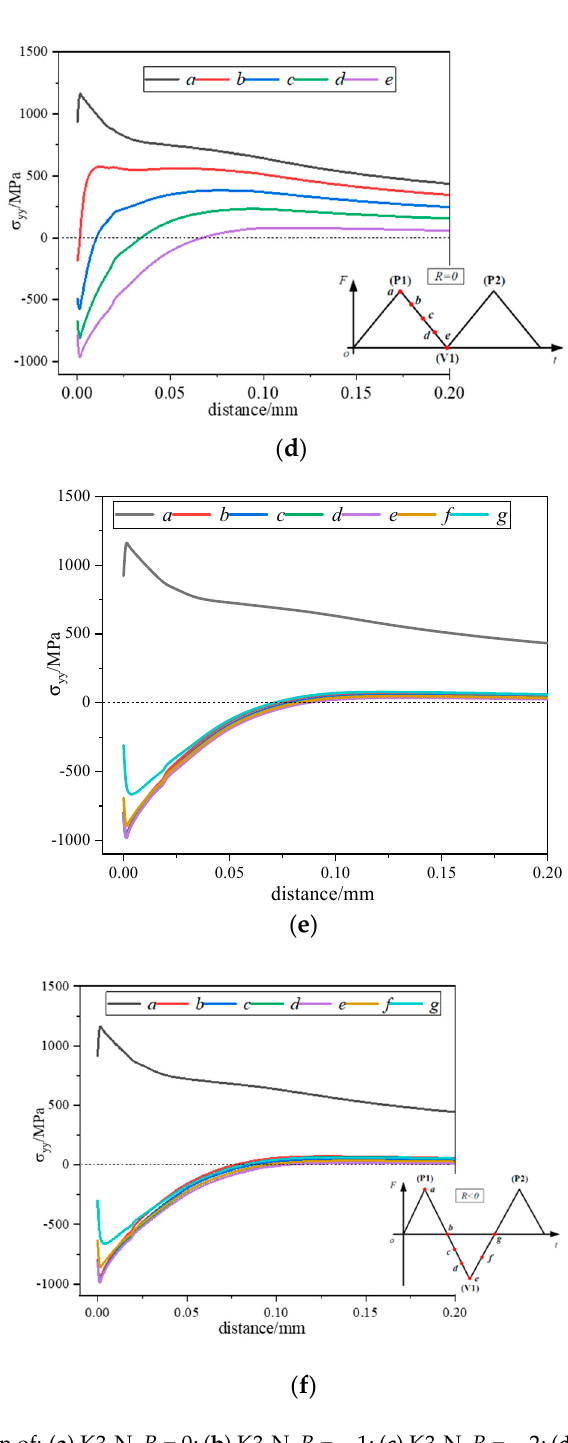
( b ) Figure 11. Effect of loading ratio R on Mises stress distribution: ( a ) Peak loading point, ( b ) Valley loading point. The results validate that crack contact closure exists at the crack tip wake zone for specimens under a negative loading ratio again, which will result in different deformation behavior ahead of the crack tip. 4.2.2. Normal Stress Distribution Normal stress ( σ yy ) fields during loading processes of a ~ g (in Figure 1) are shown in Figure 12. For specimens under R = 0 in Figure 12(a,d), normal stresses at peak points a